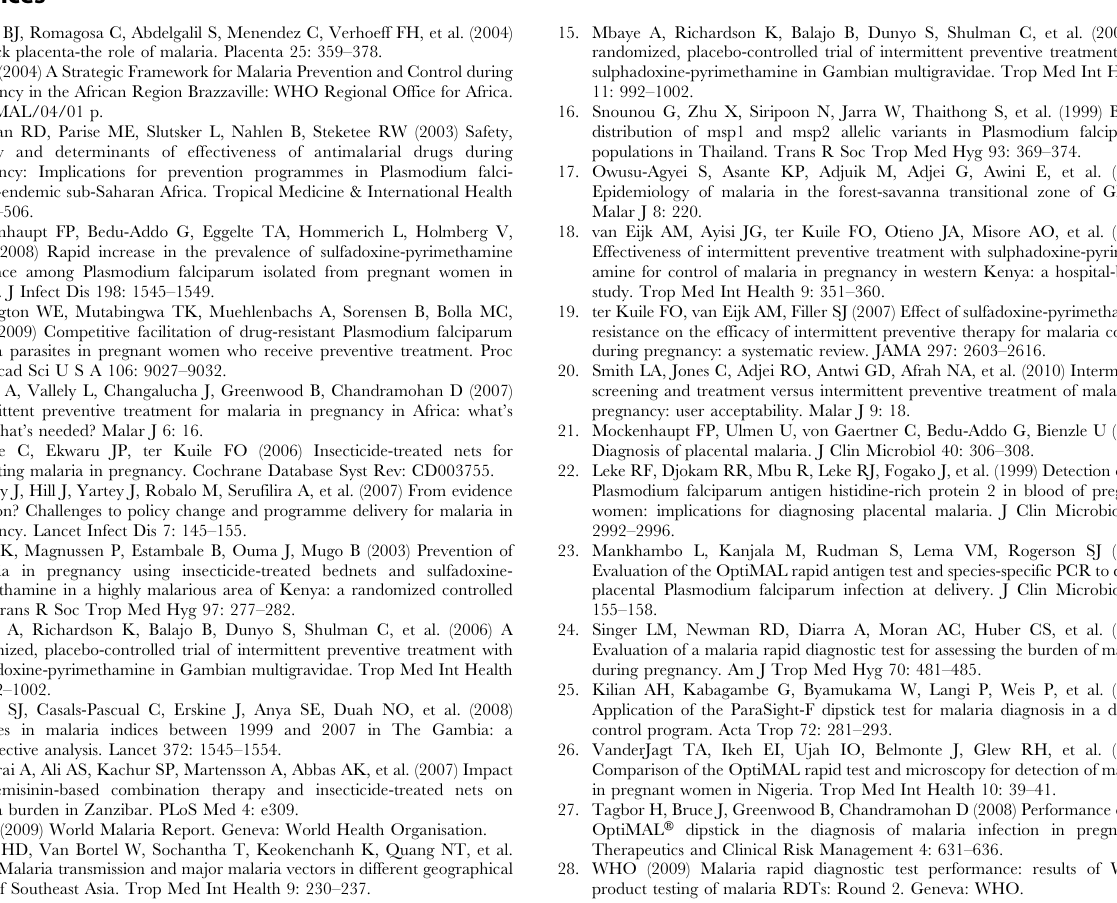
Table S6 Factors associated with low birth weight of